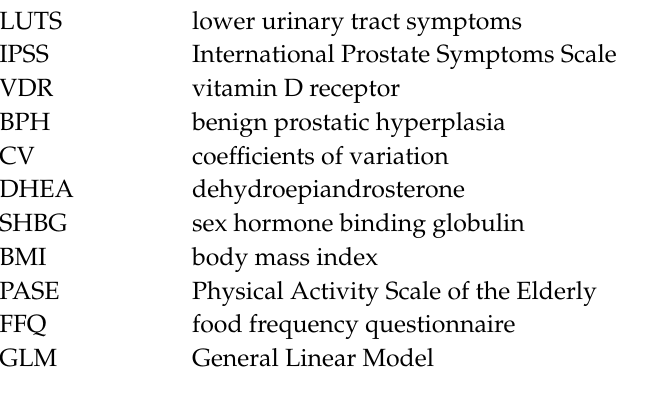
Table S1: Results of univariate analysis between serum 25(OH)D level and International Prostate Symptoms Score (IPSS) change at four-year follow-up by adjusting serum hormone levels in elderly men with baseline 25(OH)D ď 60 nmol/L ( n =